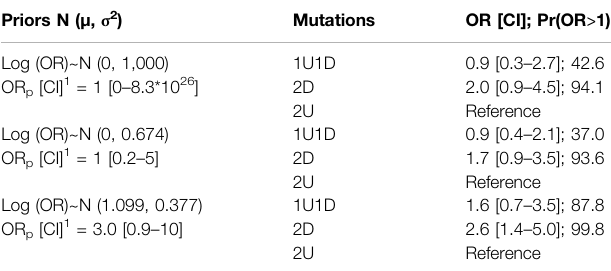
TABLE 4 | Ordinal logistic regression odds estimates. Risk of having a more severesubtypedependingonthepositionofthemutationswiththreedifferent priors. OR, odds ratio; CI, credibility intervals; Pr(OR > 1), probability that the OR is higher than 1 (%). 1: OR p [CI], odds ratio a priori with its credibility interval used to determine prior distribution for the model